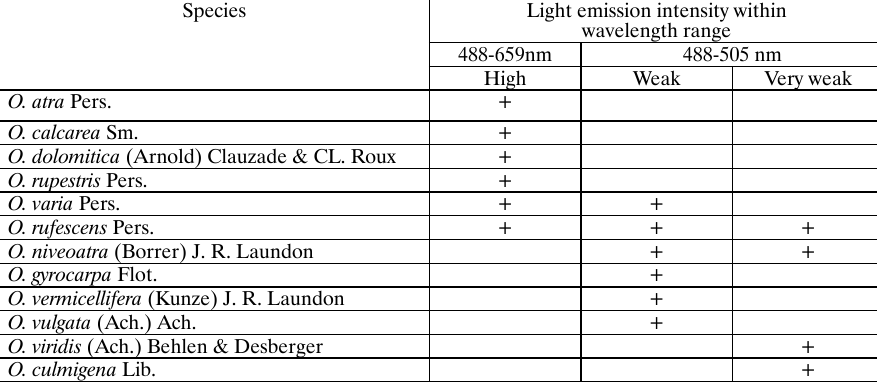
Autofluorescence intensity of ascospores in selected lichen species of the Opegrapha